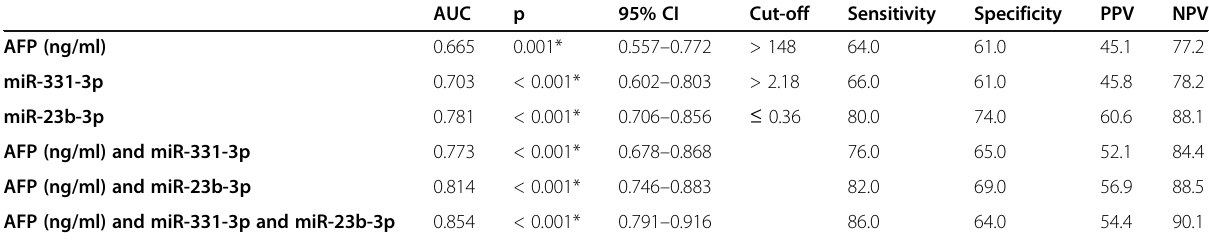
Table 3 Agreement (sensitivity, specificity) for AFP, miR-331-3p, and miR-23b-3p for diagnosing early-stage HCC